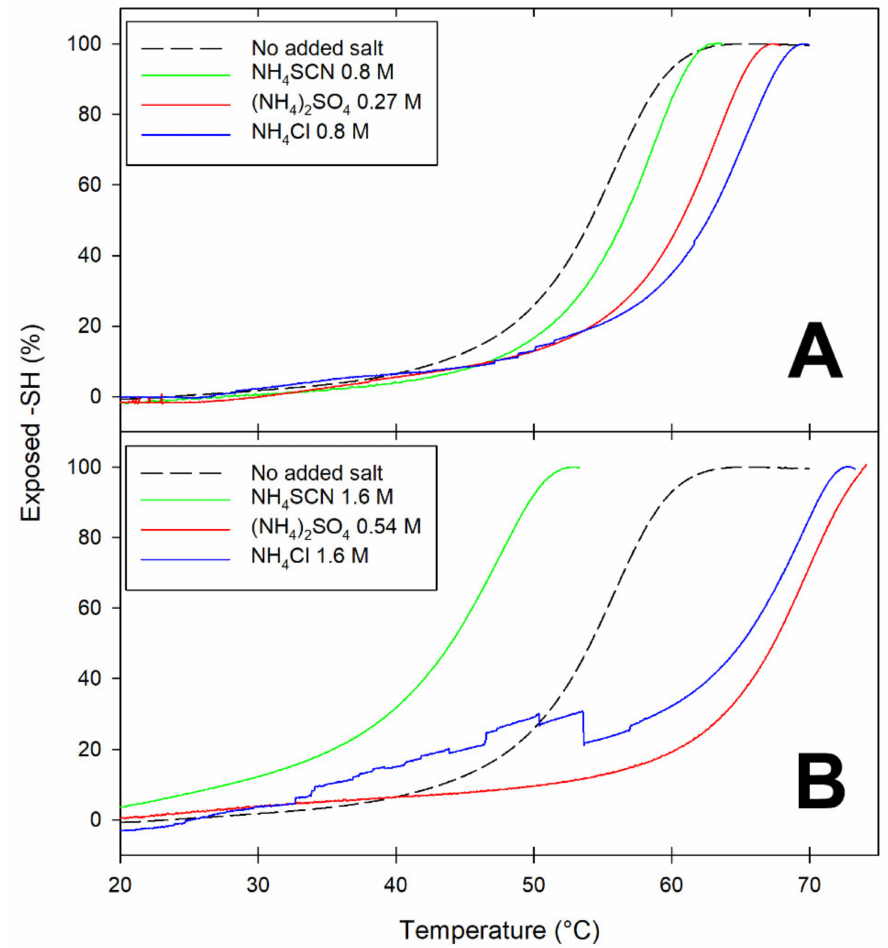
Figure 2. A comparison of the temperature dependence of the exposure of the Cys121 thiol as a function of the salt type and concentration. A BLG solution (1 mg/mL in 50 mM phosphate buffer, pH 6.8, containing 0.5 mM DTNB and the given salt concentrations) was progressively heated in a Peltier-controlled thermostated cell at a rate of 0.5 ◦ C/min, with continuous monitoring of the absorbance of the solution at 412 nm. ( A ): salt concentrations corresponding to an ionic strength of 0.8 M; ( B ): salt concentrations corresponding to an ionic strength of 1.6